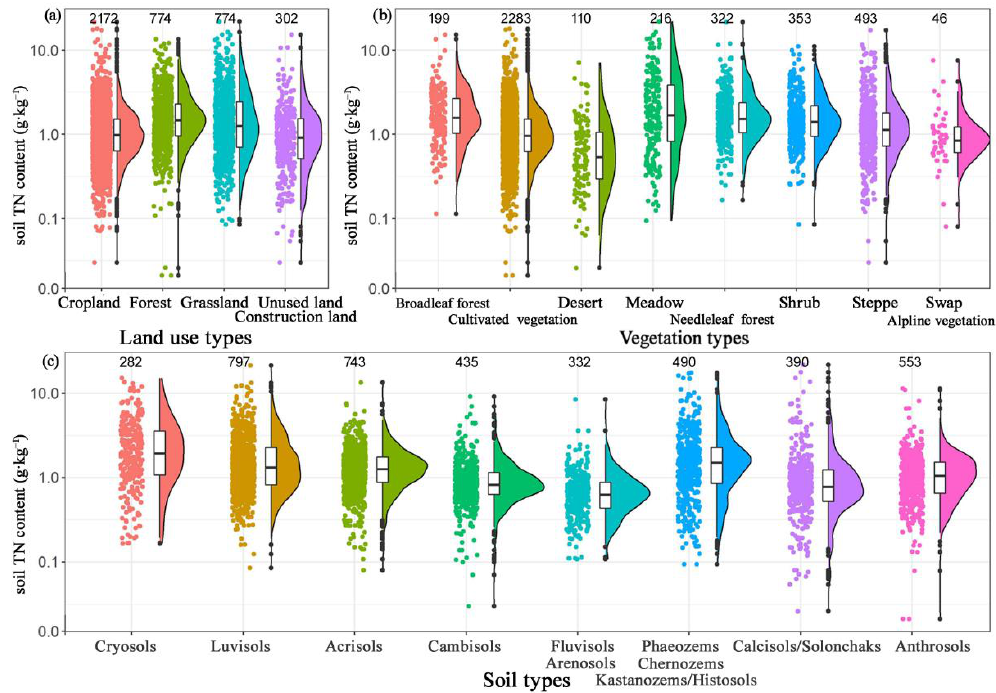
Figure 2. Raincloud plot of soil TN content in different ( a ) land use types, ( b ) vegetation types and ( c ) soil types. The “water” group is omitted because it is empty.